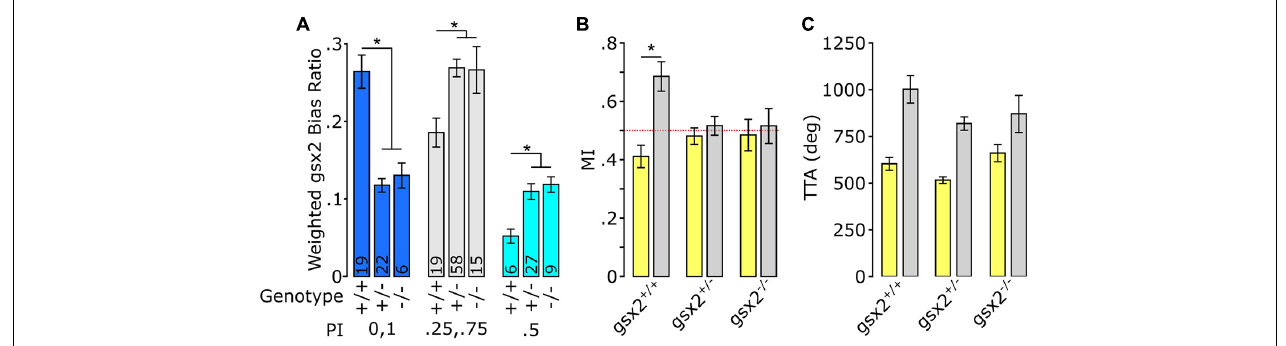
FIGURE 6 | Loss of gsx2 reduces inter-individual variation. (A) Effect of gsx2 genotype on weighted average bias ratio per performance groups (Matched: PI = 0,1; Partial PI = 0.25,0.75; and Unbiased PI = 0.5). Numbers on bars indicate N . Weighing was based on the percent of larvae within each PI per genotype. (B) MI shows that only gsx2+/+larvae maintain persistent same-direction turning following the loss of illumination. Dotted line at 0.5 indicates random movement. (C) TTA between genotypes is not affected (gsx2+/+, N = 45; gsx2 ± , N = 113; gsx2–/–, N = 32). Baseline (yellow) and dark (gray) responses in (B,C) . Asterisk p < 0.05.